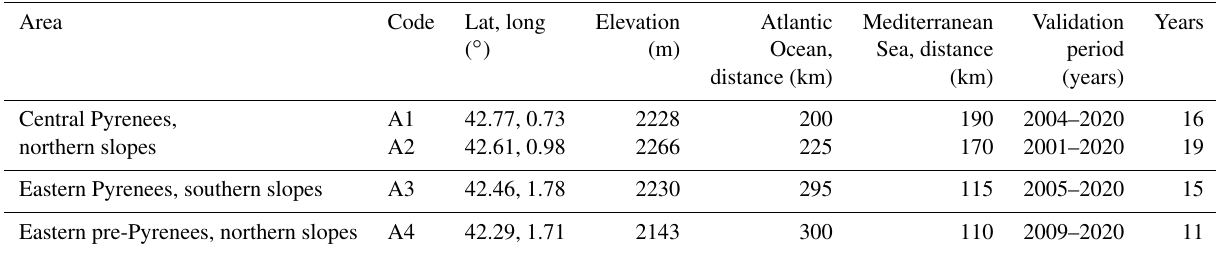
Table 1. Characteristics of the four AWSs. Area Code Lat, long Elevation Atlantic Mediterranean Validation Years ( ◦ ) (m) Ocean, Sea, distance period distance (km) Central